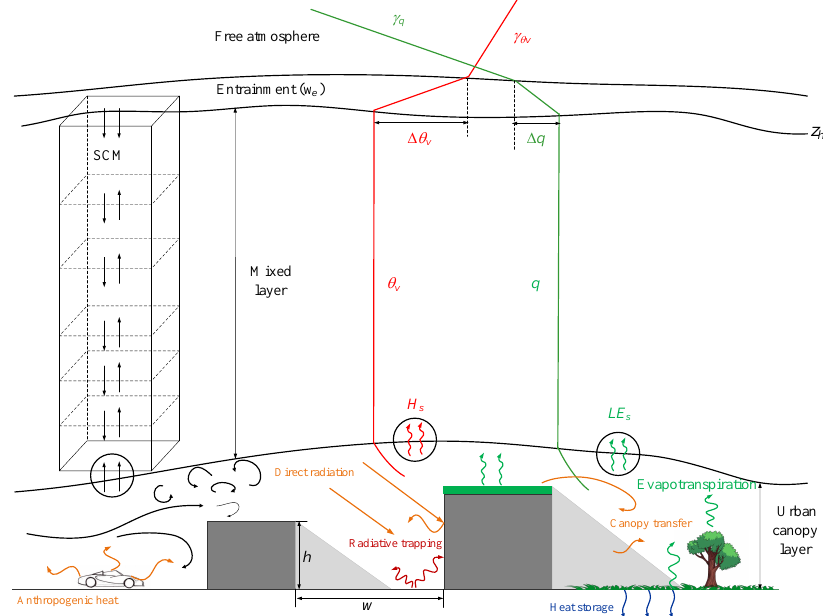
Figure 1. Schematics of coupled SLUCM–SCM framework: land surface processes are parameterized by a single layer urban canopy model; atmospheric processes under convective condition are parameterized by a single column